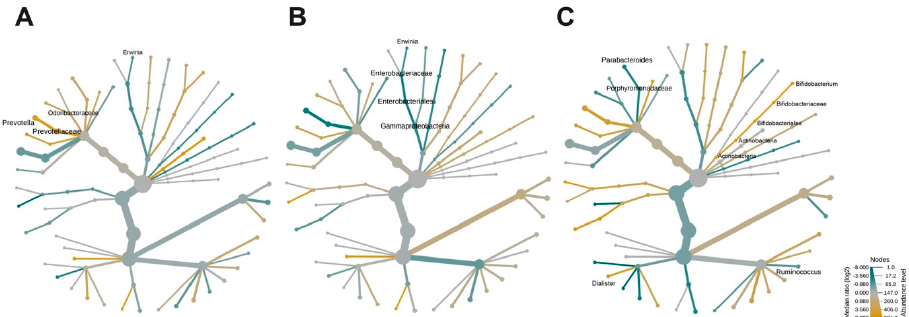
Figure 3. Effects of age-related BMD on bacterial community composition. Heat tree for pair-wise comparison, divided by BMD-age, ( A ) middle-age women (ages 45–59 years), ( B ) middle-old women (60–74 years), and ( C ) old women (>74 years). The color of each taxon indicates the log-2 ratio of proportions observed in each condition. Only those taxa that were statistically significant using the Wilcox rank sum test followed by a Benjamin–Hochberg correction (FDR) for multiple comparisons are shown as colored. Taxa colored green are enriched in the low-BMD group and those colored yellow are enriched in the normal-BMD group.